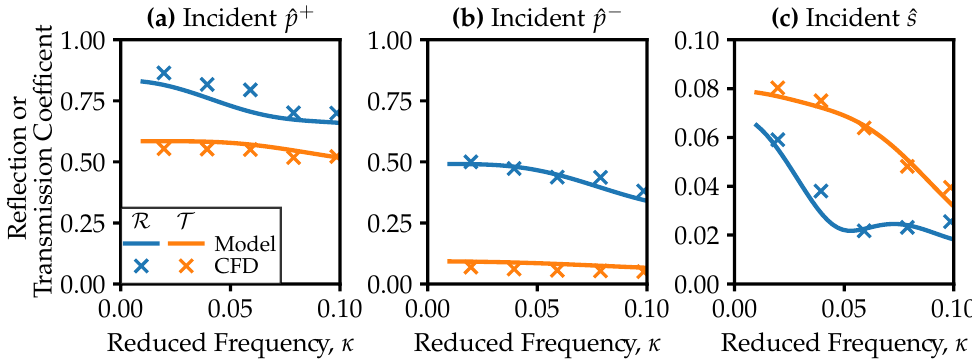
Figure 6. Comparison of reflection and transmission coefficients for a two-dimensional turbine stage, predicted by cambered analytical model and CFD. The predictions agree on average to within for downstream-running pressure wave reflection, and